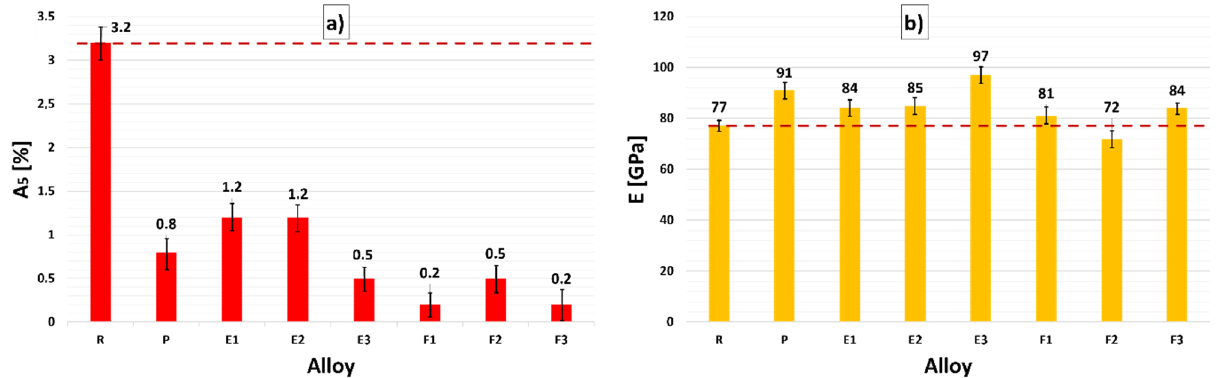
Figure 13. Dependence of ( a ) elongation A and ( b ) modulus of elasticity E after heat treatment for R, P, and experimental alloys E1–E3 and F1–F3.